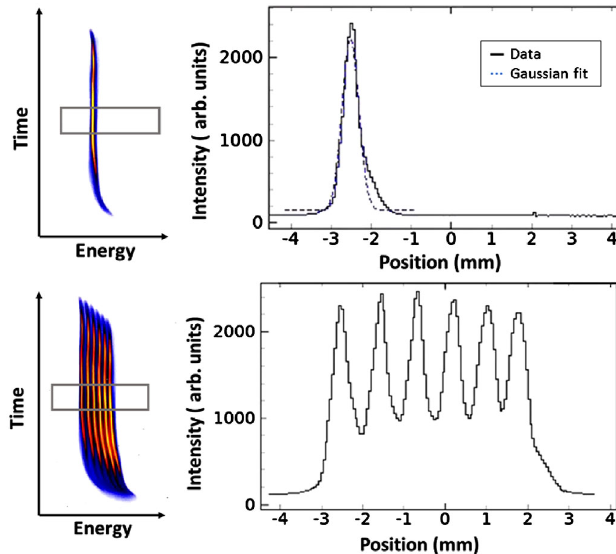
FIG. 6. Longitudinal phase-space measurements at the rf diagnostic line with a transverse deflecting cavity and a YAG profile monitor for bunch charges of 75 pC. The beam images (left) show at the top a single macrobunch and at the bottom a train of six macrobunches. The intensity profiles (right) are taken over the indicated windows and are used to determine the energy distribution, including differences along the six-macrobunch train.